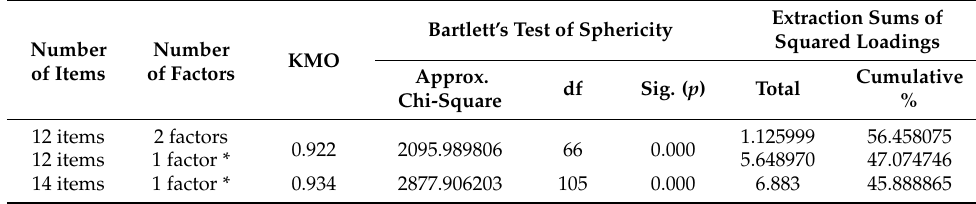
Table 8. Subscales and factor analyses results.